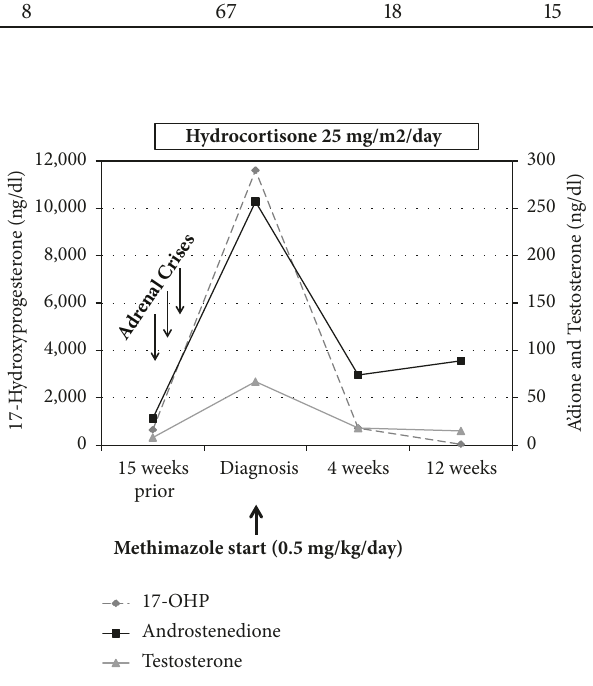
Figure 1: Graphic demonstration of adrenal androgen levels over